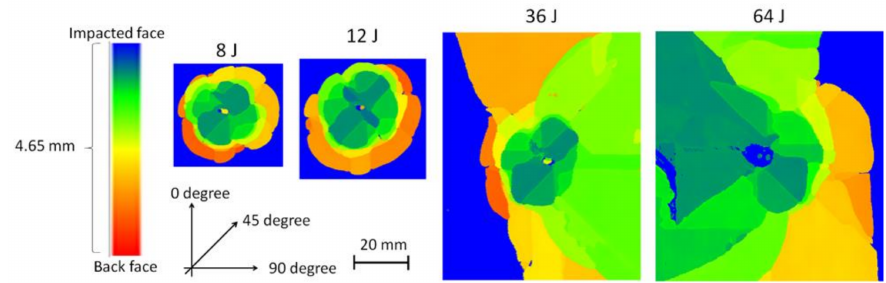
Figure 10. C-scan images of the laminate with various impact